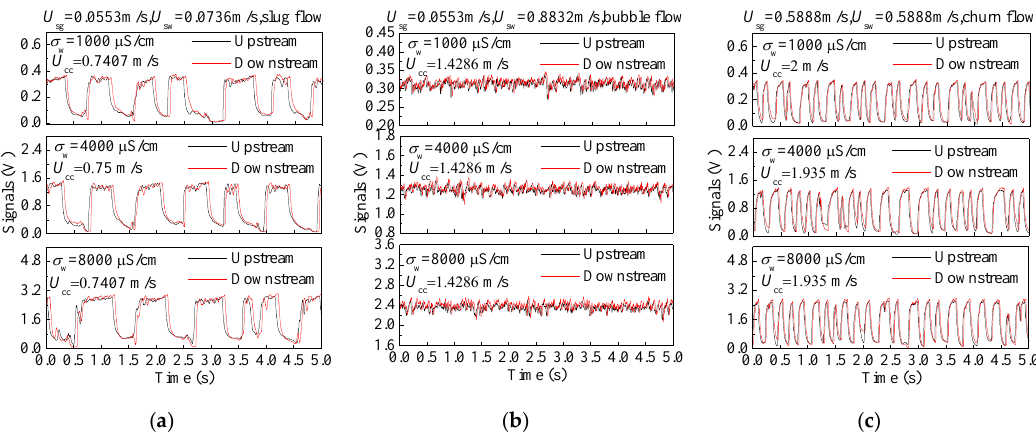
Figure 11. The signals of the velocity sensor and calculation results under three typical flow patterns and different water conductivities: ( a ) Slug flow; ( b ) Bubble flow; ( c ) Churn flow.